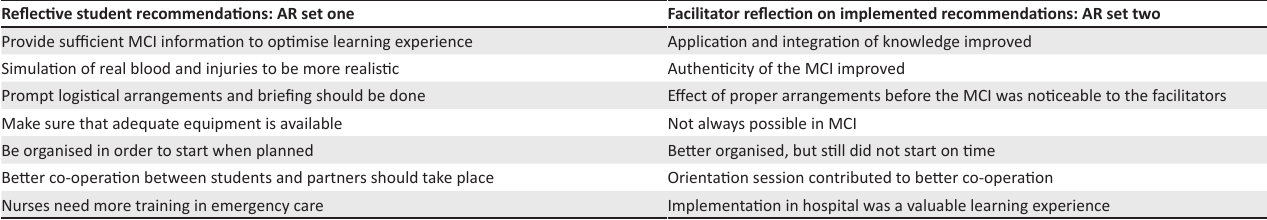
TABLE 5: Reflective recommendations made in action research set one and the effect of its implementation in action research set two. Reflective student recommendations: AR set one